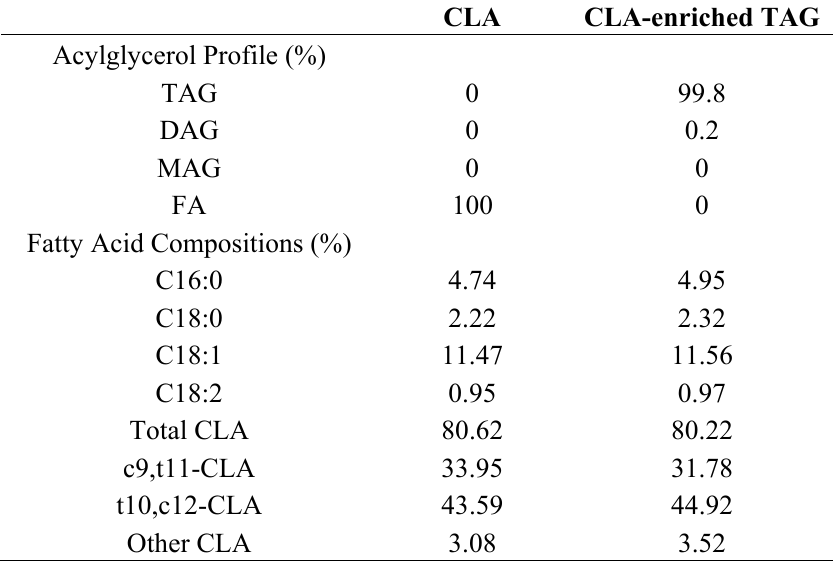
Table 3. Acylglycerol profile, fatty acid composition of extremely pure CLA-enriched